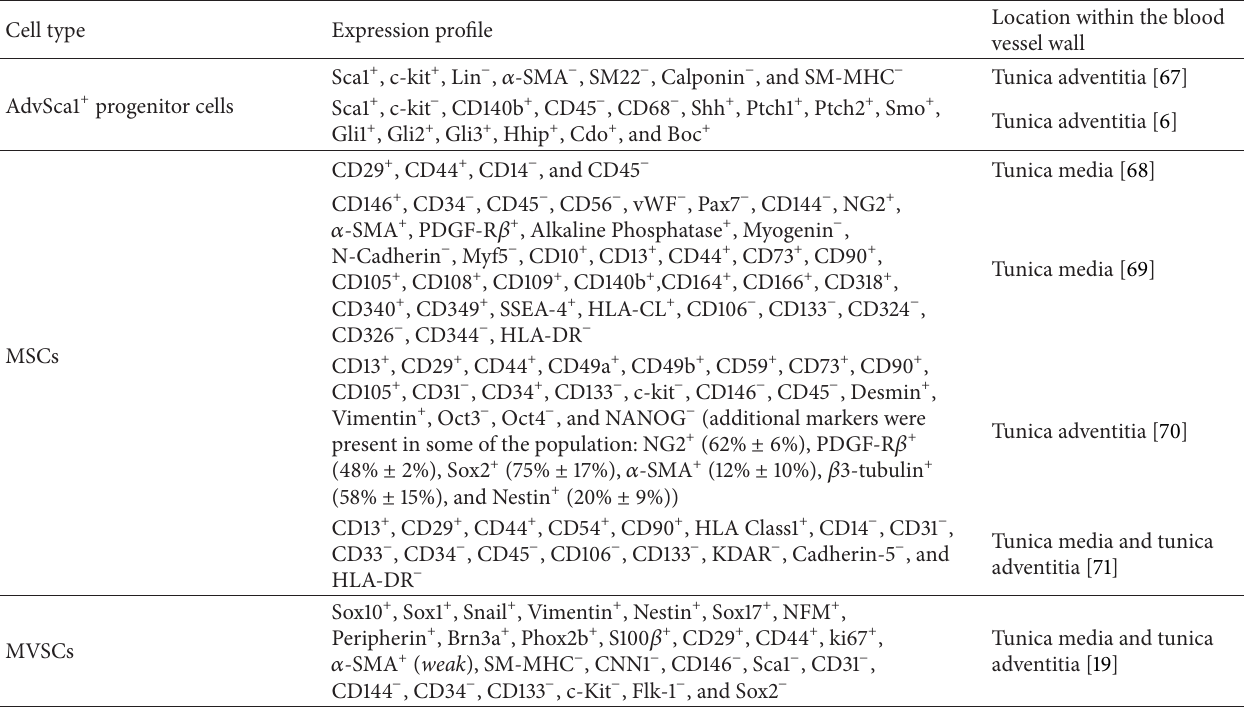
Table 1: Expression profiles and locations of resident stem and progenitor cells within the blood vessel